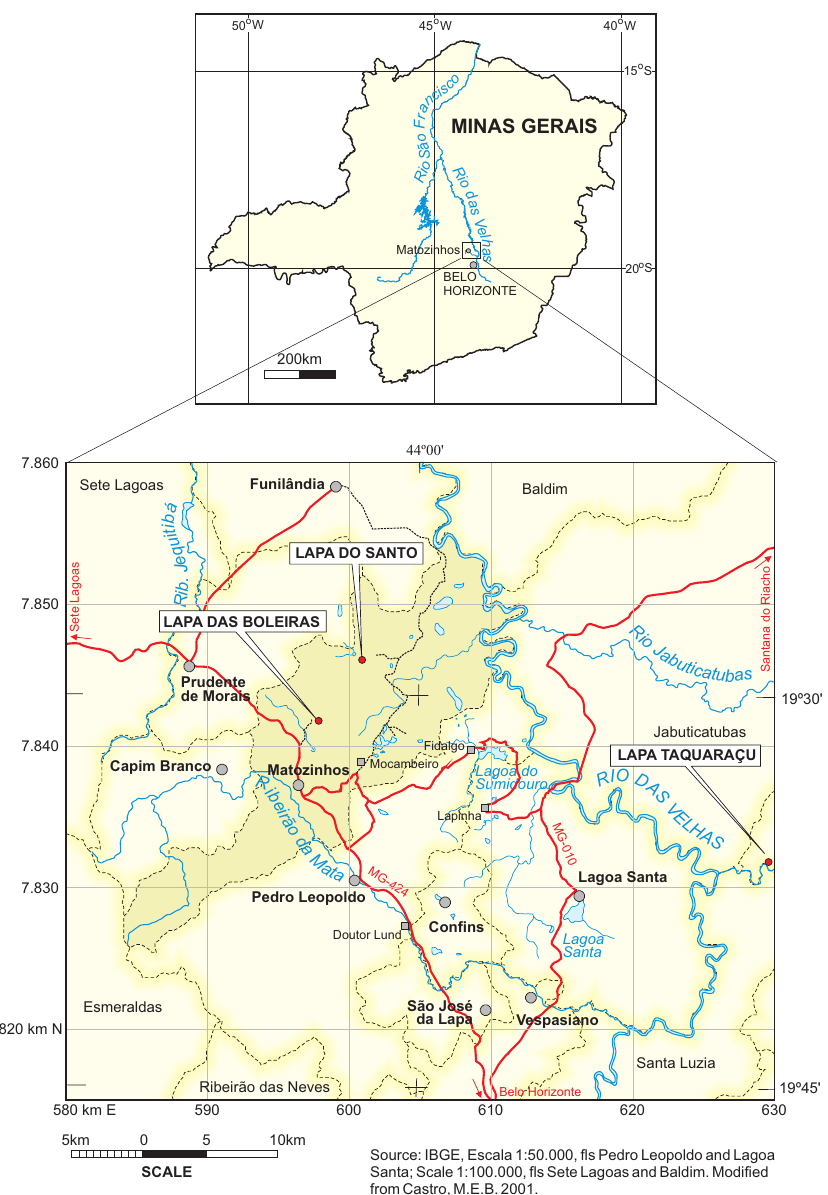
Figure 2 - Location of Lagoa Santa region and sites mentioned in the